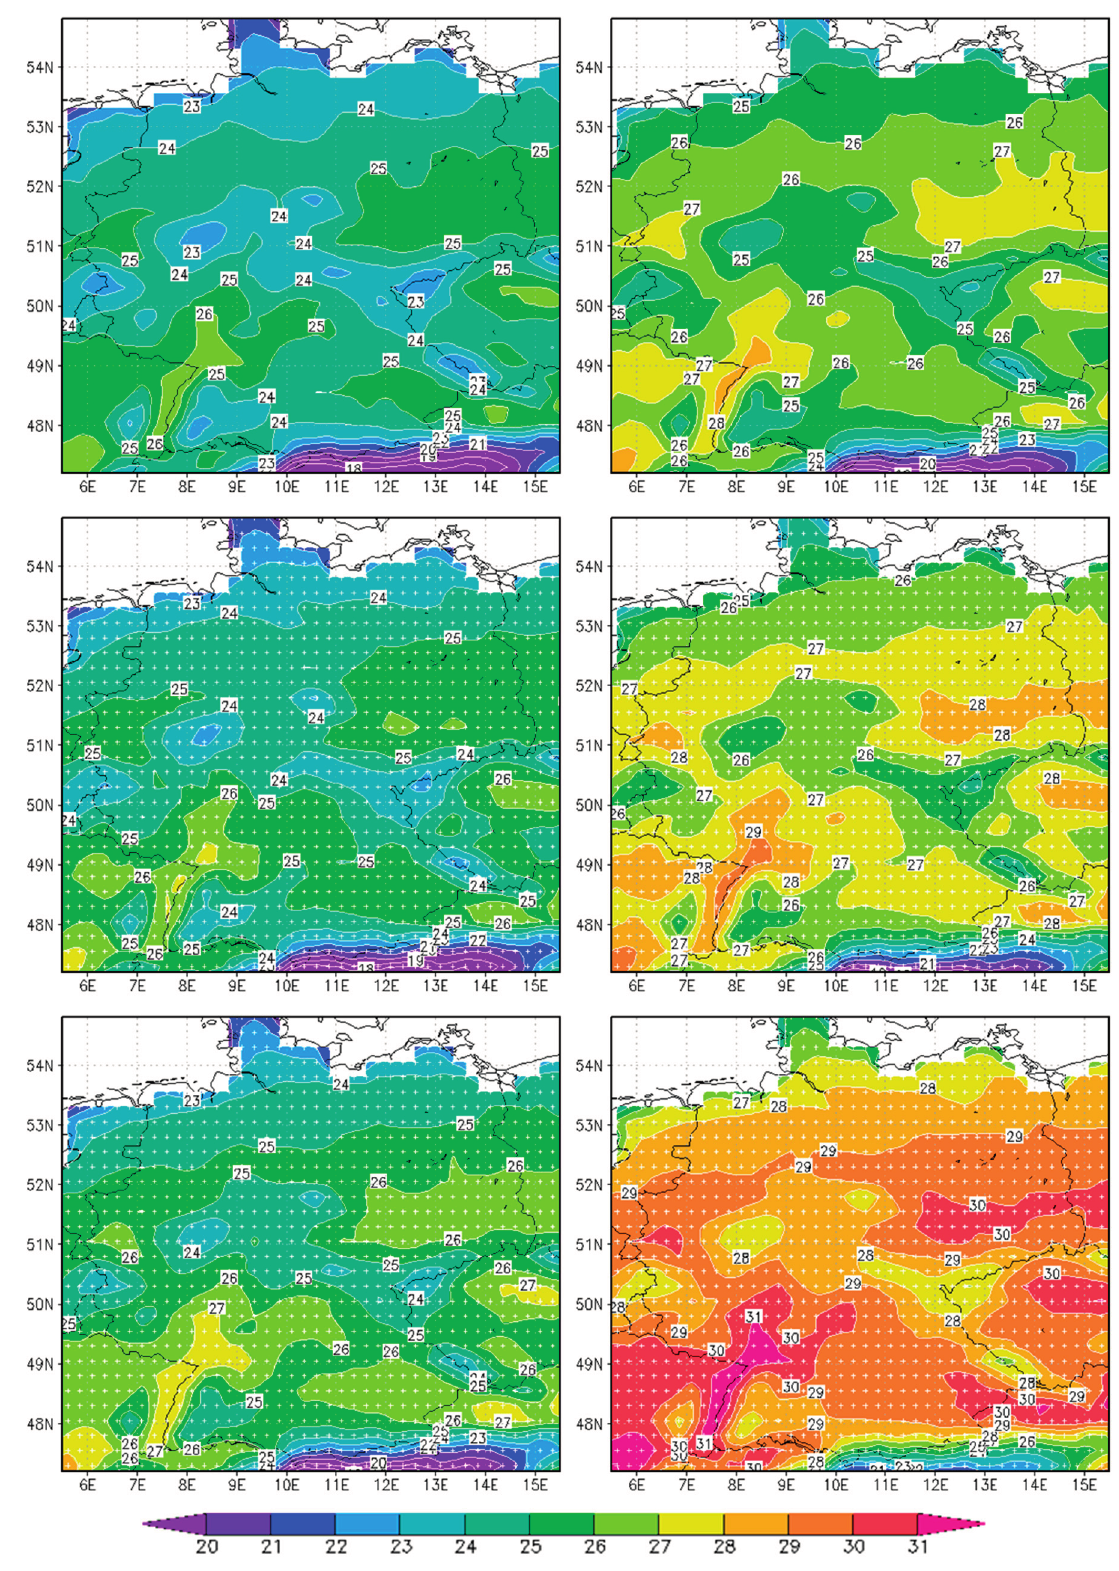
Figure 3. Projected ensemble mean of the average heat wave intensity ( left ) and amplitude ( right ) in degrees Celsius for 1971–2000 ( top ), 2021–2050 ( center ) and 2069–2098 ( bottom ). Grid points with significant changes ( α < 0.05) between present and future climate are marked by white